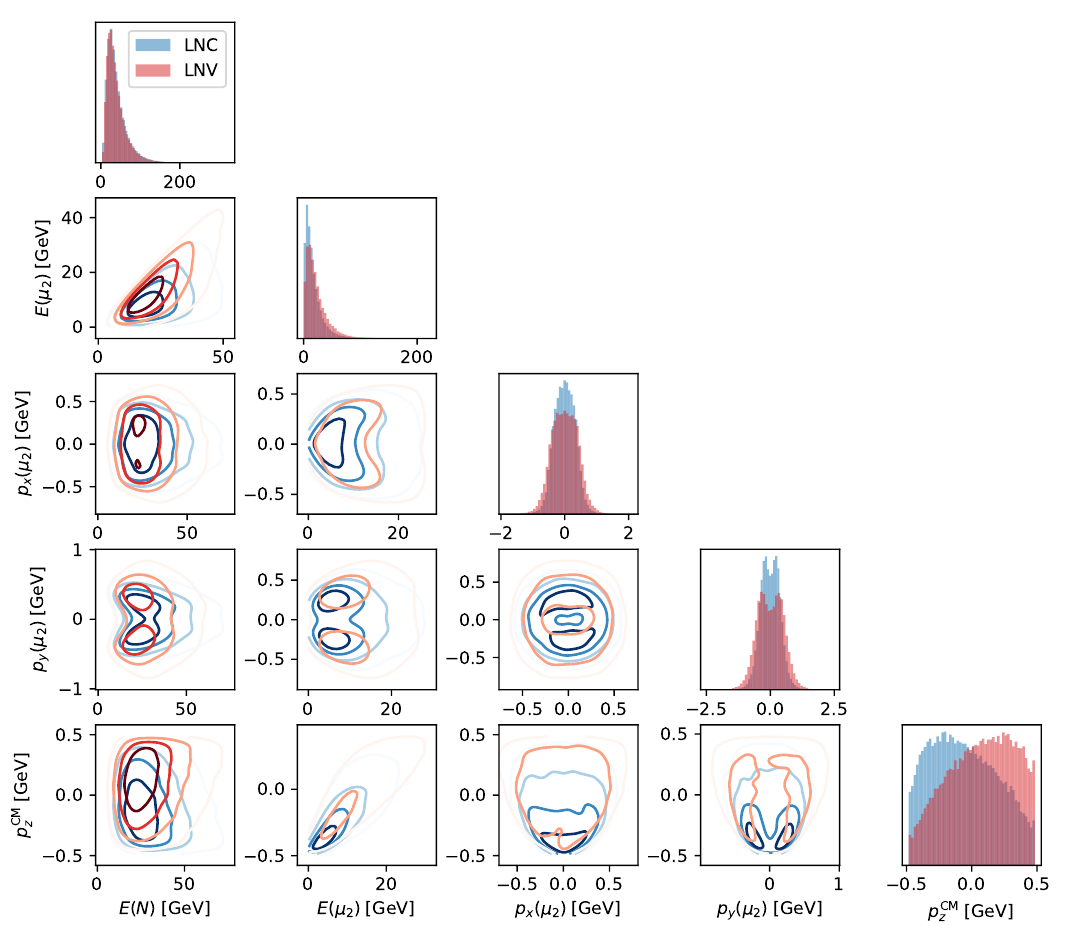
Figure 7. Corner plot showing the correlations between (cid:12)ve selected features, for a 1 GeV HNL coupling to the muon. See table 1 for a description of the features. Each subplot shows, on the same scale, the marginal distributions of LNC and LNV events as a function of either one (on-diagonal plots) or two (o(cid:11)-diagonal plots) features. 1d distributions are represented as histograms, and 2d distributions as contour plots of the probability